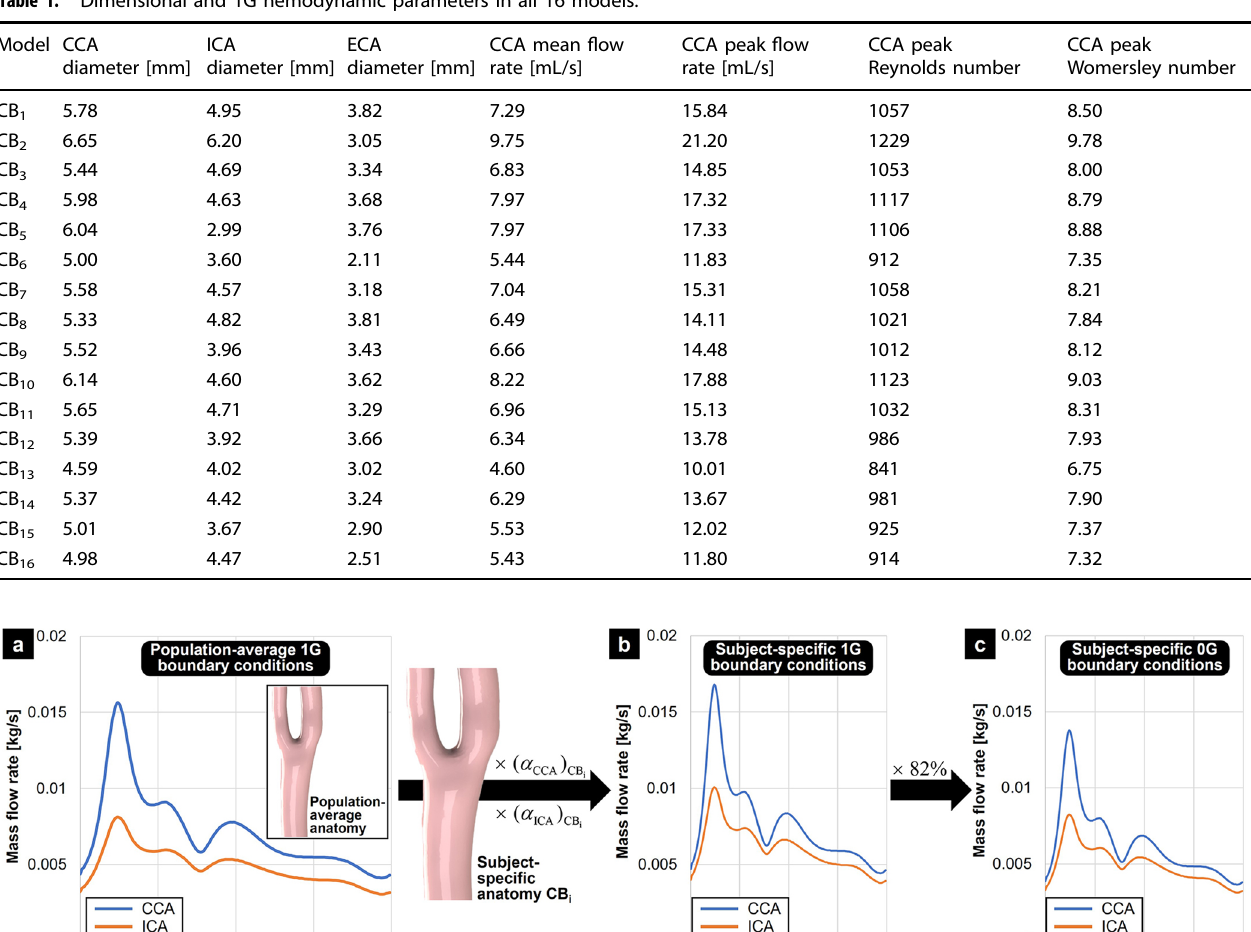
Table 1. Dimensional and 1G hemodynamic parameters in all 16